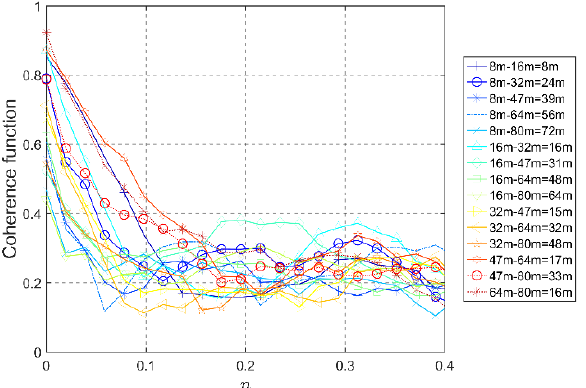
Figure 15. Coherence function with frequency obtained by the field measurement.